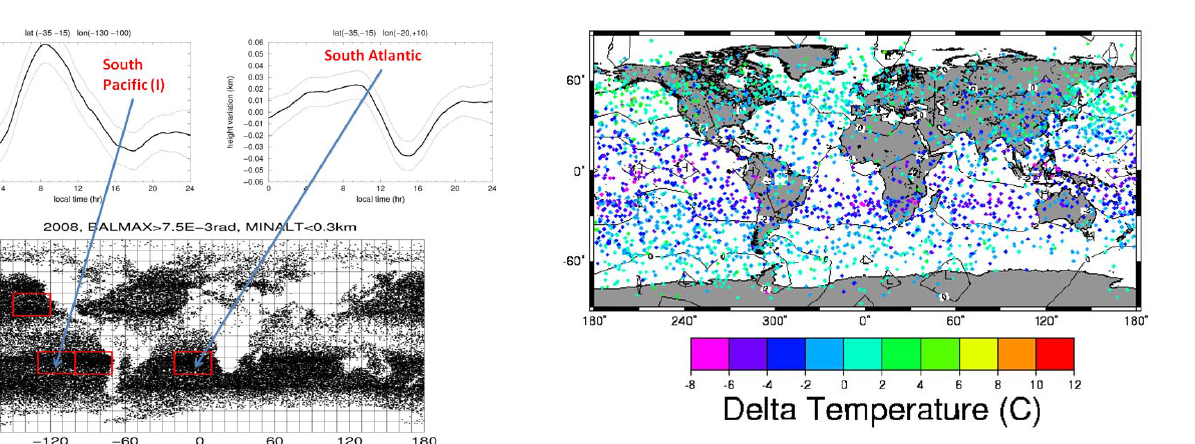
Fig. 26. GPS/MET minus NCEP-NCAR reanalysis temperatures ( ◦ C) at 100hPa 6 January–27 February 1997. Note the systematic differences in the equatorial regions between GPS/MET and NCEP. NCEP is significantly warmer than GPS/MET in the equatorial re- gions and somewhat cooler in middle latitudes (Anthes et al.,